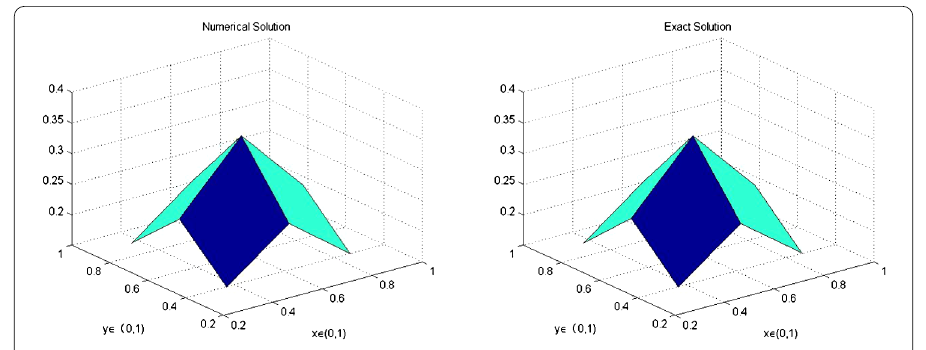
Figure 3 The effect of numerical solution and exact solution at fixed T = 1, h = 1 ( a ) N = 2 2 . ( b ) N = 2 2